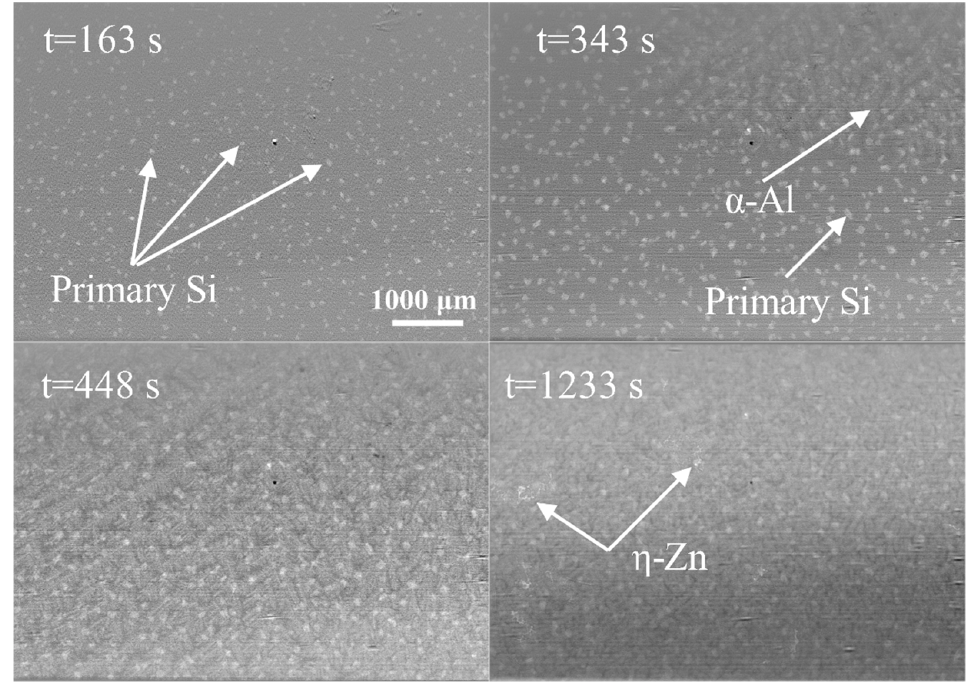
Figure 8. Synchrotron radiation images of Al-40Zn-6Si alloy during solidification at different times.